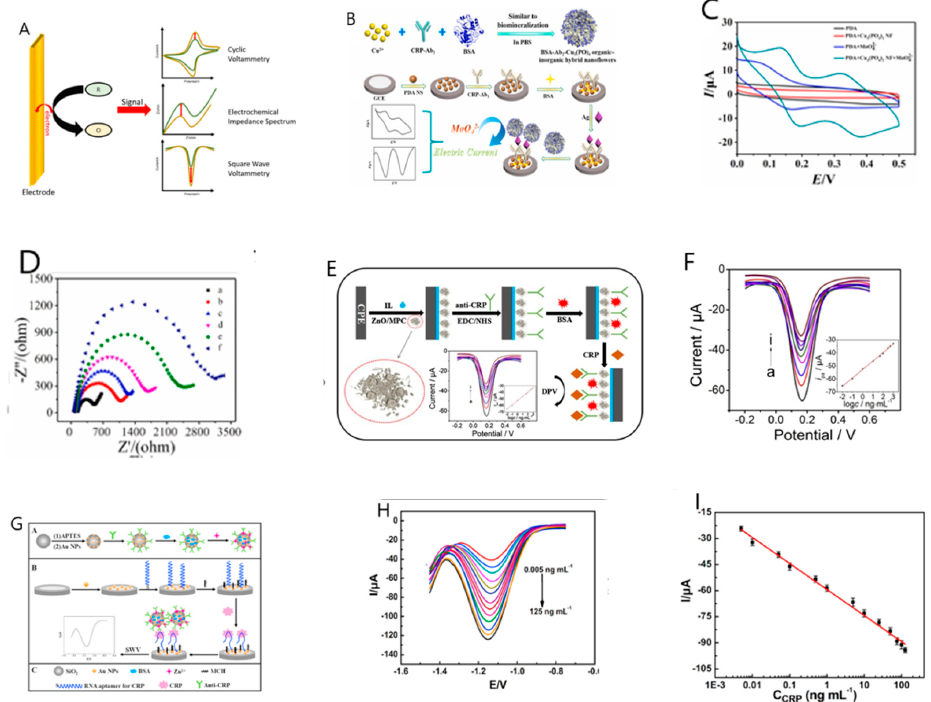
Figure 2. ( A ) Electrochemical sensor basic structure. ( B ) Illustration of the synthesis procedure of BSA-Ab2-Cu3(PO4)2 hybrid nanoflowers as signal labels, fabrication process of the electrochemical immunosensor. ( C ) Cyclic voltammetry (CV) of polydopamine nanospheres (PDANS) modified electrode (black line), BSA-Ab2-Cu 3 (PO4) 2 nanoflowers on the modified electrode (red line), and sodium molybdate reaction with (green line), without BSA-Ab2-Cu 3 (PO4) 2 nanoflowers on the modified electrode (blue line). ( D ) Electrochemical Impedance Spectrum (EIS) responses recorded at different mod- ified electrodes in 5.0 mM [Fe(CN) 6 ] 3-/4- and 0.1 M KCl. From curve a to curve f: bare GCE; PDANS/GCE; Ab1/PDA NS/GCE; BSA/Ab1/PDANS/GCE; CRP/BSA/Ab1/PDANS/GCE; BSA-Ab2-Cu 3 (PO4) 2 /CRP/BSA/Ab1/PDANS/GCE, respec- tively. ( E ) Schematic diagram of the processes to prepare C-reactive protein (CRP) immunosensor. ( F ) Differential Pulse Voltammetry (DPV) responses of BSA/anti-CRP/ZnO/MPC/IL-CPE to different CRP concentration (0.01, 0.1, 1, 10, 50, 100, 300, 500, 1000 ng·mL − 1 ). Inset: linear relationship of current (Ip) vs. logarithm (logc). ( G ) Schematic diagram of the pro- cesses to prepare CRP aptasensor. ( H ) Square Wave Voltammetry (SWV) recorded of the aptasensor at different concen- trations of CRP (0.005, 0.01, 0.05, 0.1, 0.5, 1.0, 5.0, 10.0, 25.0, 50.0, 75.0, 100.0, 125.0 ng mL − 1 ) in 0.2 M HAc-NaAc (pH 5.5). ( I ) Calibration curve of the peak current vs the logarithmic concentration of CRP. (Reproduced with permission from [62,71,77] published by Elsevier 2019, 2017). Table 2. Summary of electrochemical biosensing techniques discussed in this review. Probe